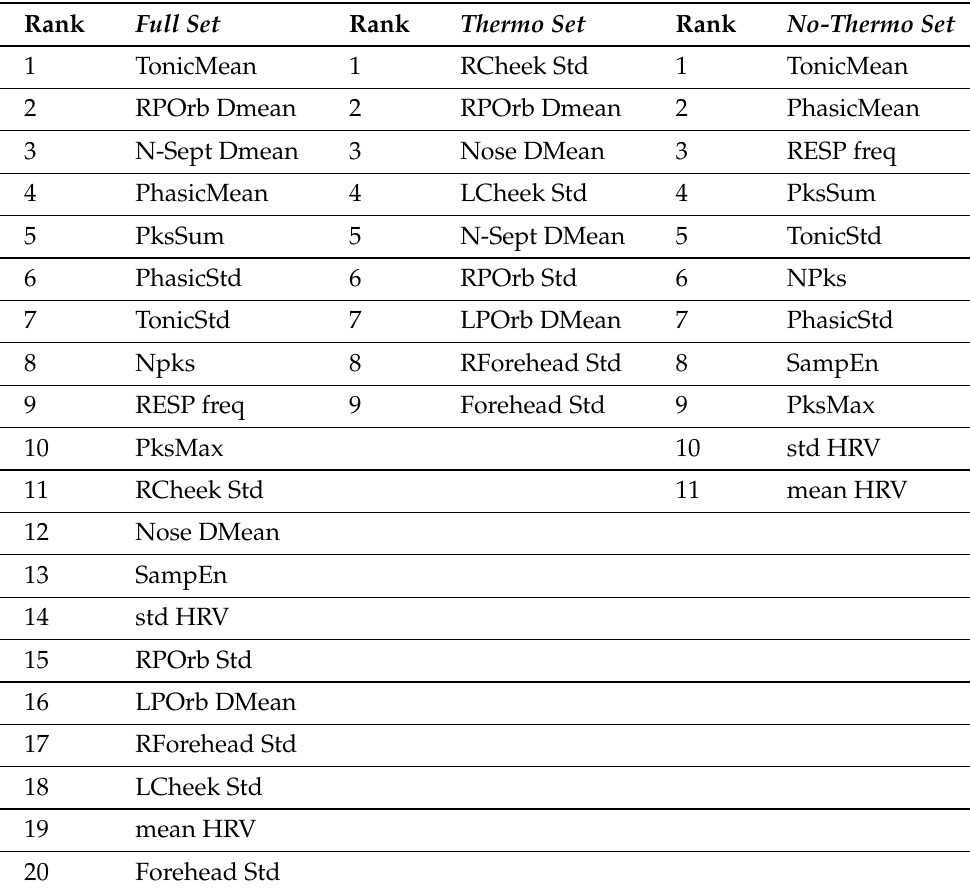
Table 1. Feature ranking according to the RFE